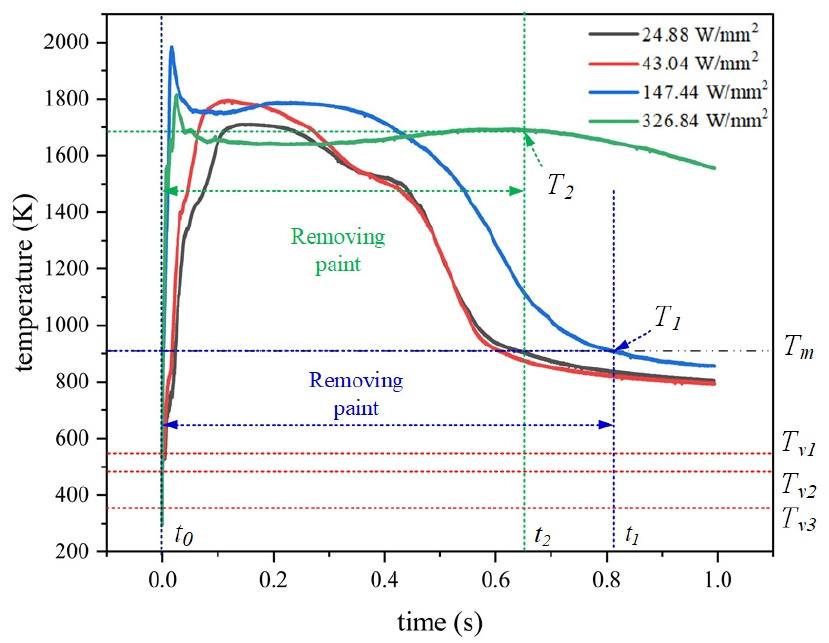
Figure 8. Temperature change of the epoxy primer, epoxy varnish, and alkyd paint during paint removal.